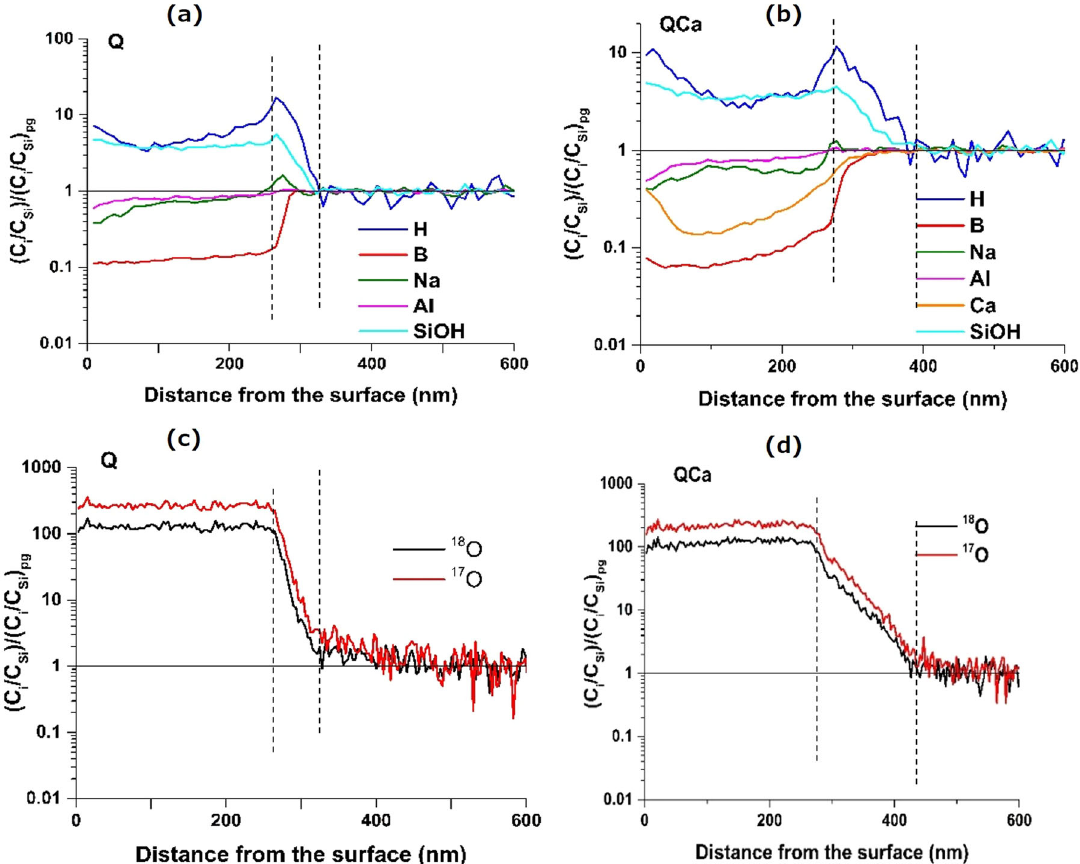
Fig. 3 ToF-SIMS. Normalized ToF-SIMS pro fi les of glass Q and glass QCa monoliths altered in vapor phase (experiments 6 ( a , c ) and 8 ( b , d